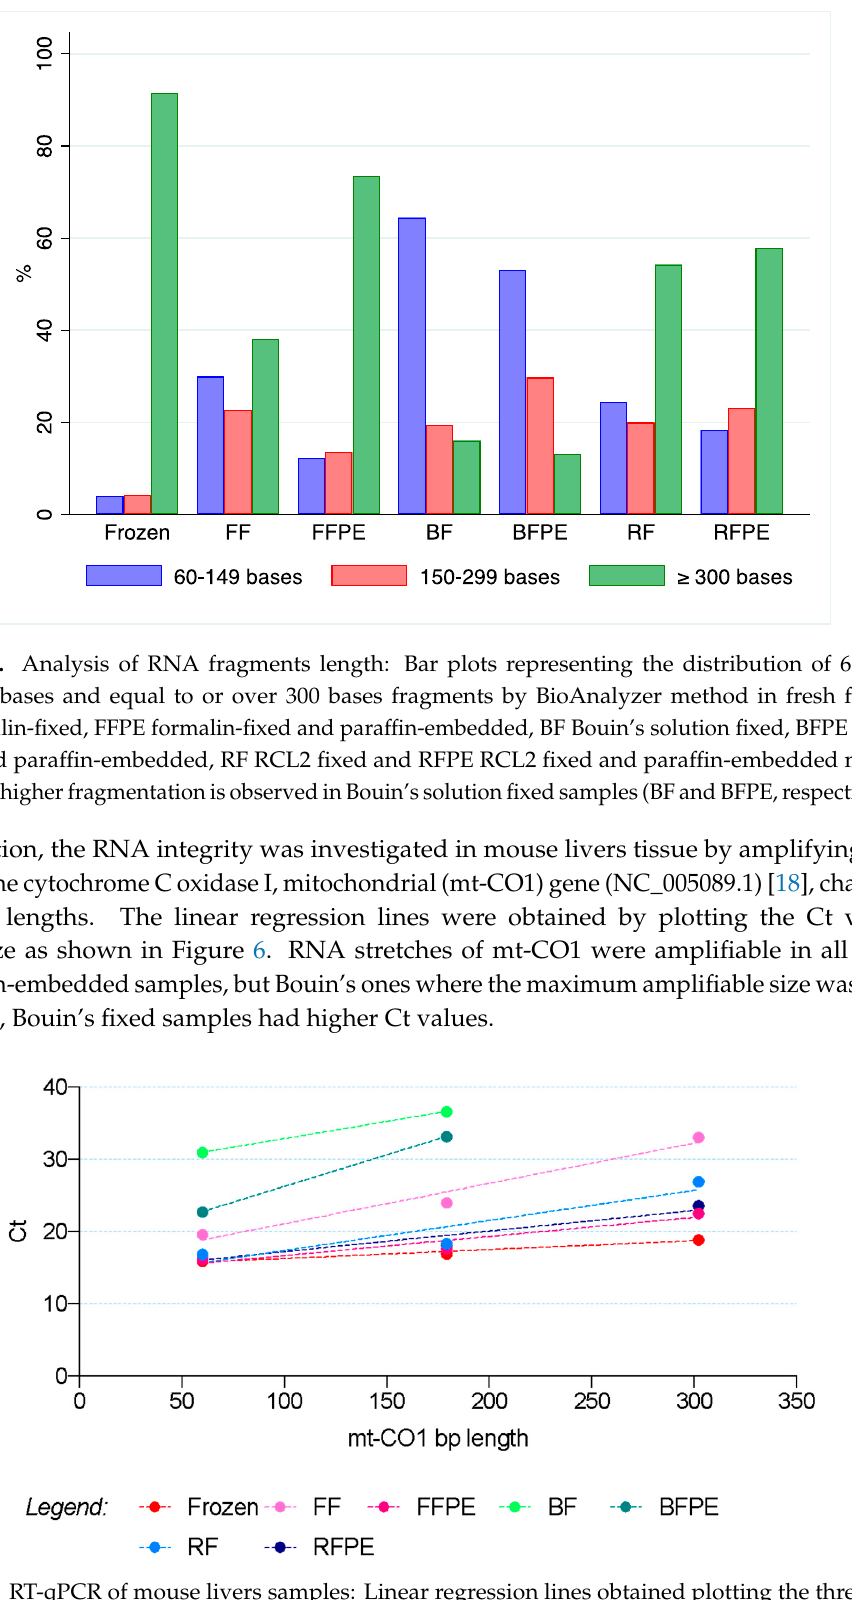
Figure 6. RT-qPCR of mouse livers samples: Linear regression lines obtained plotting the threshold cycle (Ct) by RT-qPCR for mitochondrially encoded cytochrome c oxidase I (mt-CO1) versus the amplicon length (bases) in mouse livers extracts. In Bouin’s solution, fixed samples (BF and BFPE, respectively) fragments of 300 bases were not amplifiable.